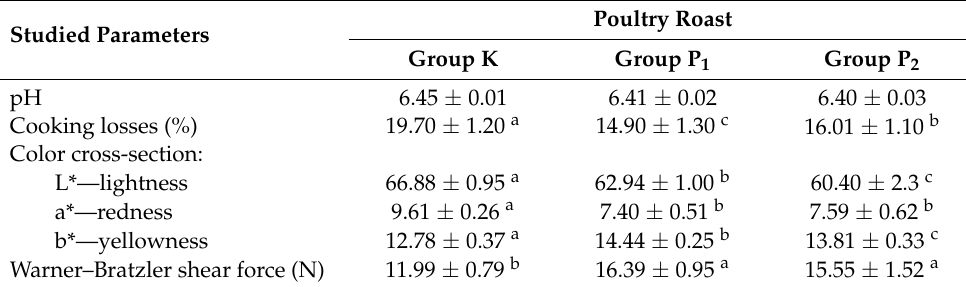
Table 2. Effect of enrichment with seeds, flour, and hemp oil on the active acidity, cooking losses, and physical characteristics of poultry roast (x ±